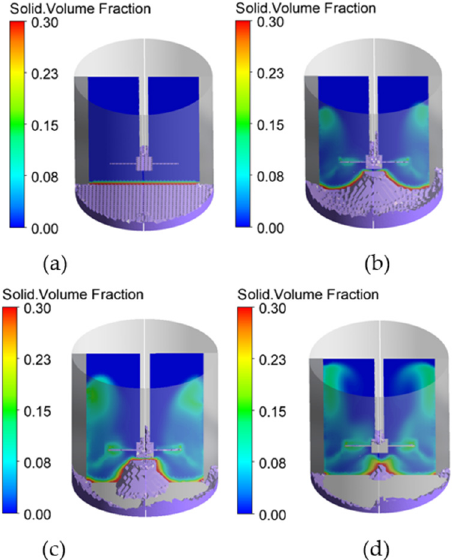
Figure 18. 3D sediment volume plot upon contour plots of solid volume fractions on a vertical diametrical plane for different impeller speeds. ( a ) N = 180 rpm, ( b ) N = 300 rpm, ( c ) N = 420 rpm, ( d ) N = 540 rpm.